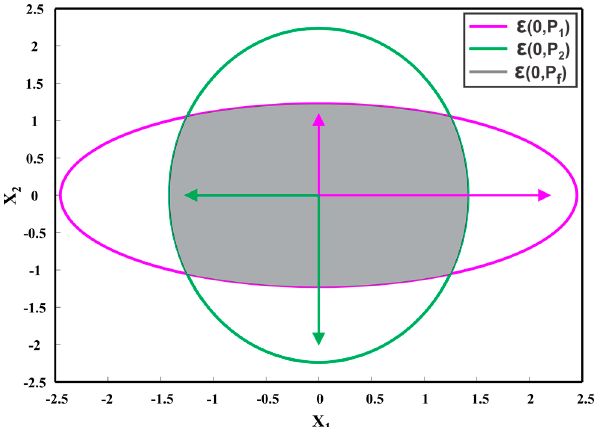
Figure 7. Illustration of fused covariance P f of individual data sources for the correlation coefficient in the range [ − 1, 1]. The gray area represents all possibilities of a fused covariance.